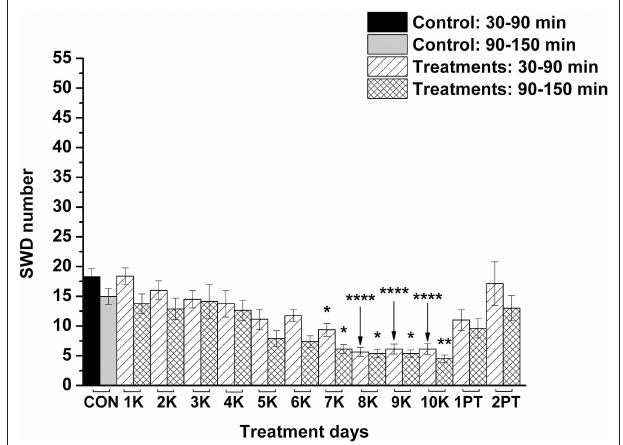
FIGURE 2 | Effect of KEKS food (20% KEKS and 1% saccharin in standard rodent chow; group 1) administration on SWD number. 1K, 1st KEKS food administration; 2K, 2nd KEKS food administration and so on; 1PT, 1st post-treatment control day; 2PT, 2nd post-treatment control day; CON, control; SWD, spike-wave discharge. * p < 0.05, ** p < 0.01, and **** p <